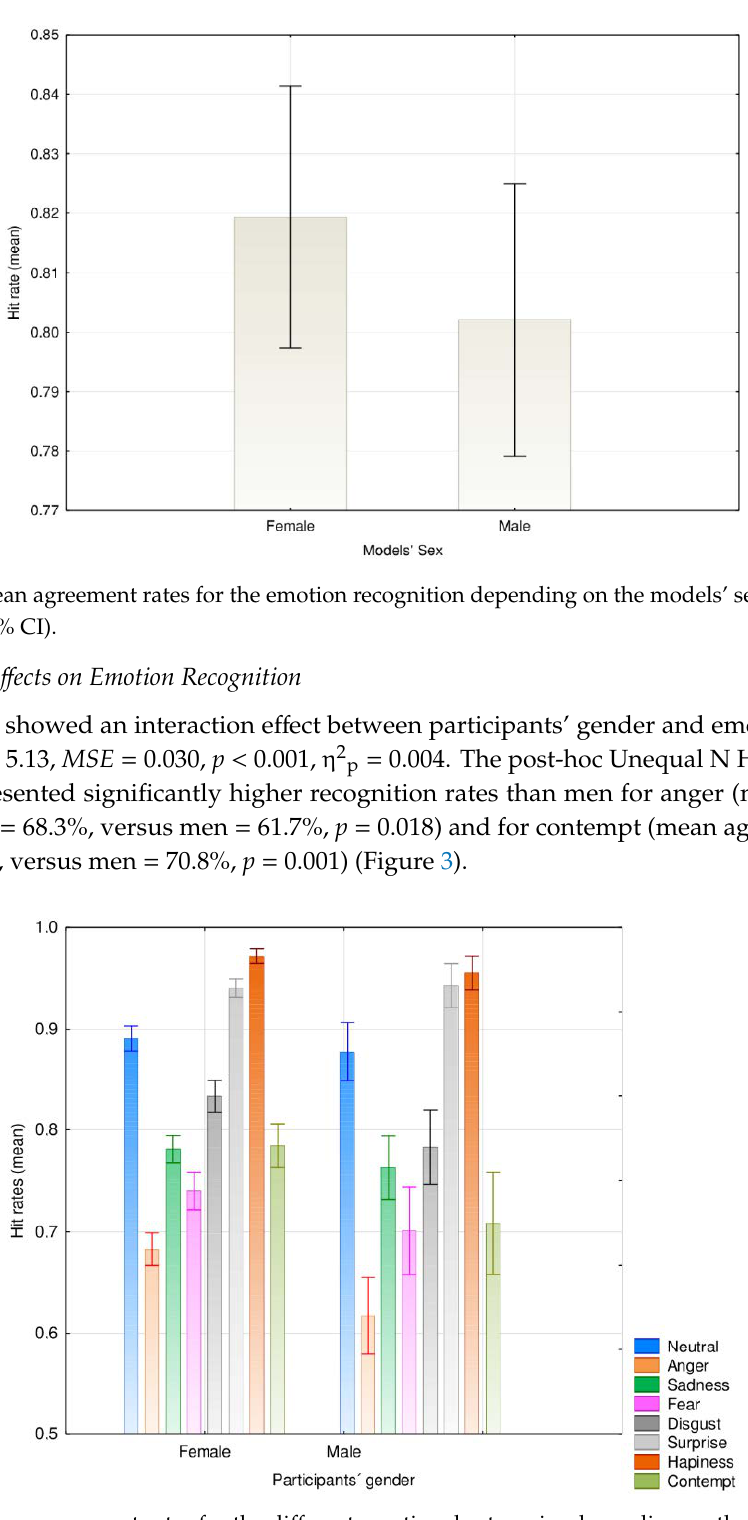
Figure 4. Mean agreement rates for the different emotional categories depending on the models’ sex (error bars represent 95% CI). 4. Discussion In the present study, the adequacy of the RaFD as a database to be employed in emotion recognition tasks among Portuguese samples was tested. One of the goals was to present normative data regarding the recognition of seven facial expressions with emotional content, plus a neutral facial expression, utilizing a forced-choice task. The other goal was to identify differences in the recognition of facial emotional expressions according to participants’ gender and according to the sex of the model expressing the emotion. The overall level of emotion recognition in this study was high and equivalent to that reported in the original study (82%), even if significant differences were found in the recognition of all emotions between the present study and the study by Langner et al. [32]. This shows that the RaFD